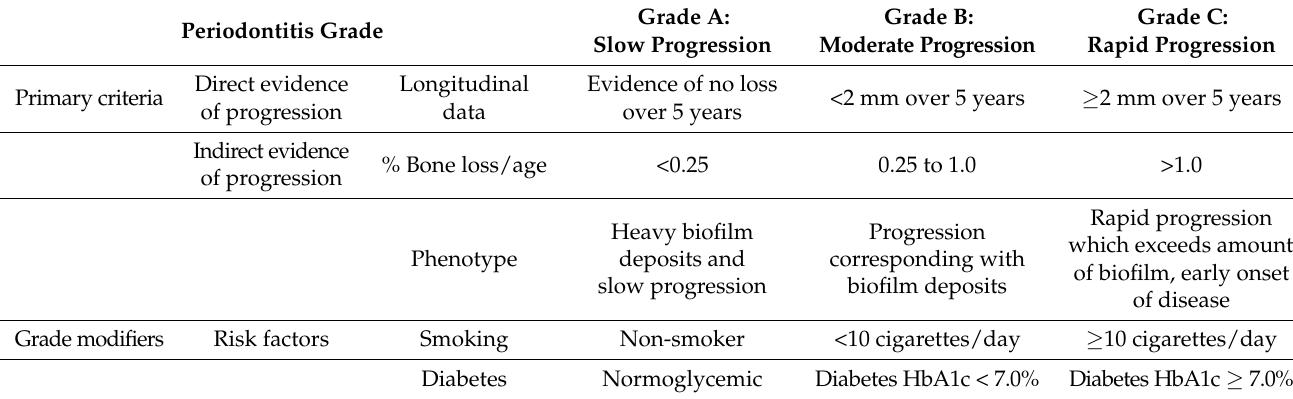
Table 2. Periodontitis